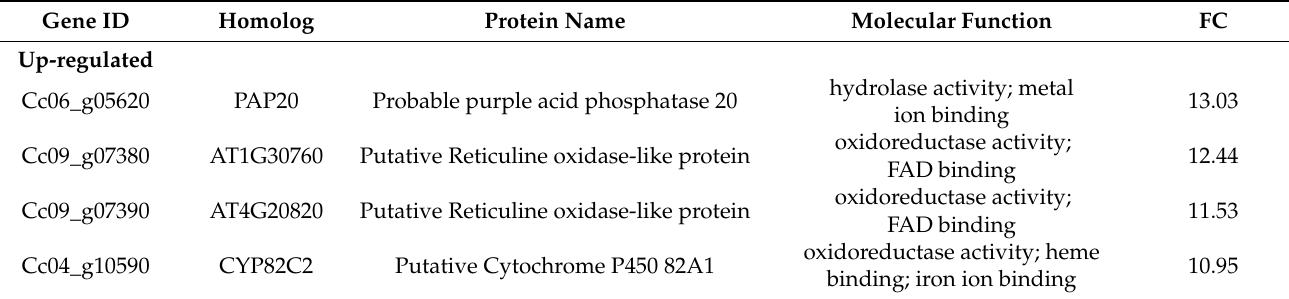
Table 2. Top 10 up and down-regulated differentially expressed genes (DEGs) under severe water deficit (SWD) relative to well-watered (WW) C. canephora cv. Conilon Clone CL153 (CL153) plants. Molecular functions were retrieved